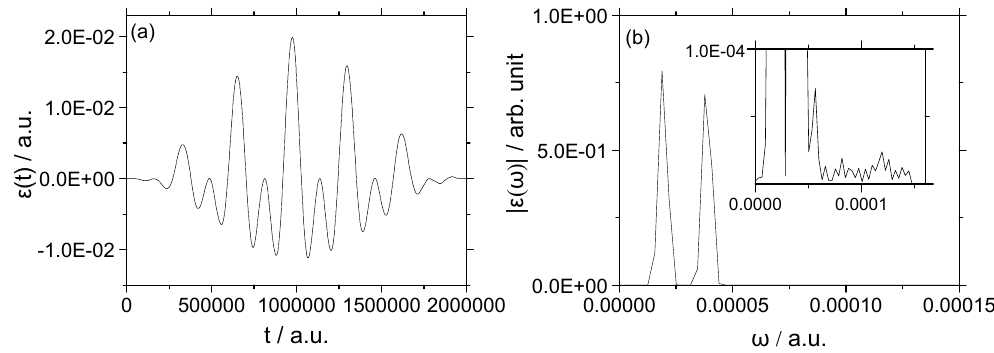
Figure 5. ( a ) The optimal field ε ( t ) obtained with the initial guess, Equation (19), for the rotational excitation, ( v = 0, J = 0) → ( v = 0, J = 2), in the strong-field regime; ( b ) the spectrum of ε ( t ).